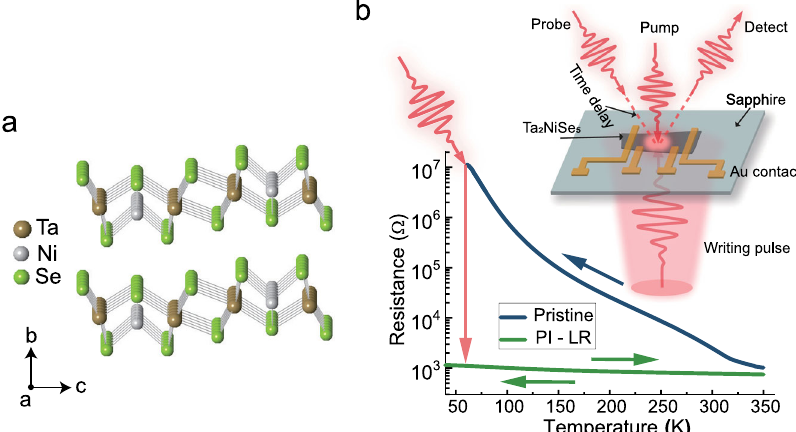
Fig. 1 Resistivity switching of Ta 2 NiSe 5 by the 35 fs laser pulse at 800 nm. a The layered crystal structure of Ta 2 NiSe 5 . A quasi one-dimensional structure is formed by a single Ni chain and two Ta chains along a-axis. b The four-probe resistance of the pristine (blue) and PI-LR state (green) after a writing excitation ~3.5 mJ/cm 2 . Inset is the schematic of the sample and experimental con fi guration. The length of dotted red line indicates the time delay between the pump and probe